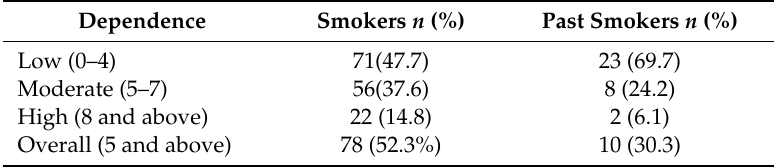
Table 2. Nicotine dependence among smokers and past smokers.